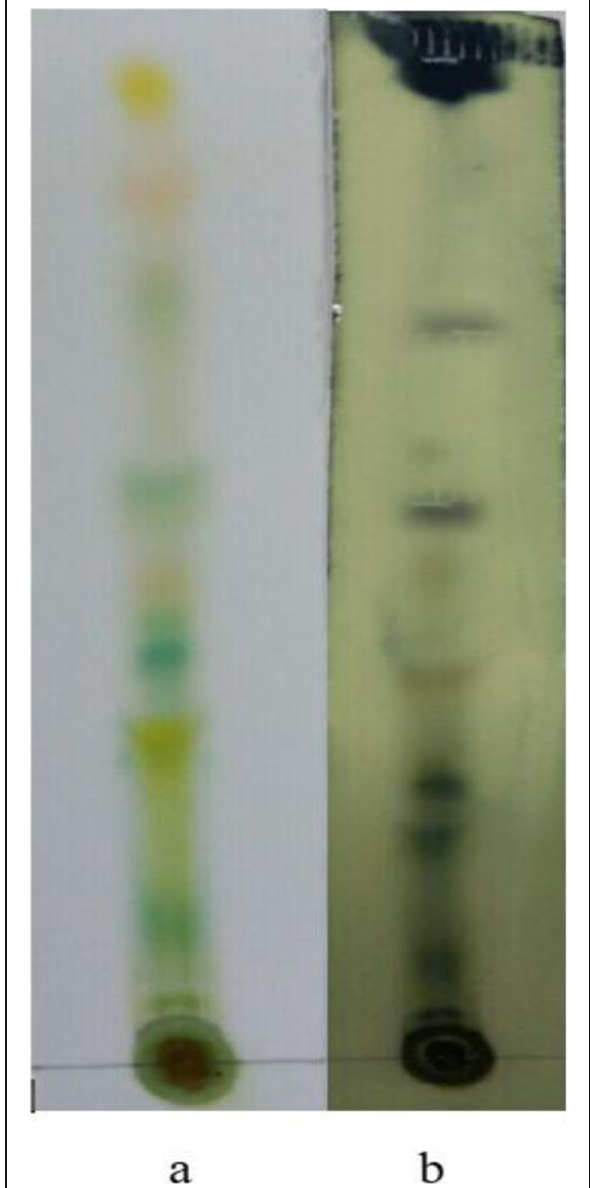
Fig. 3 Detection of phenolic compounds in the aqueous extract from S. platensis with a light treatment visible and b visible, after sprayed with Folin-Ciocalteu